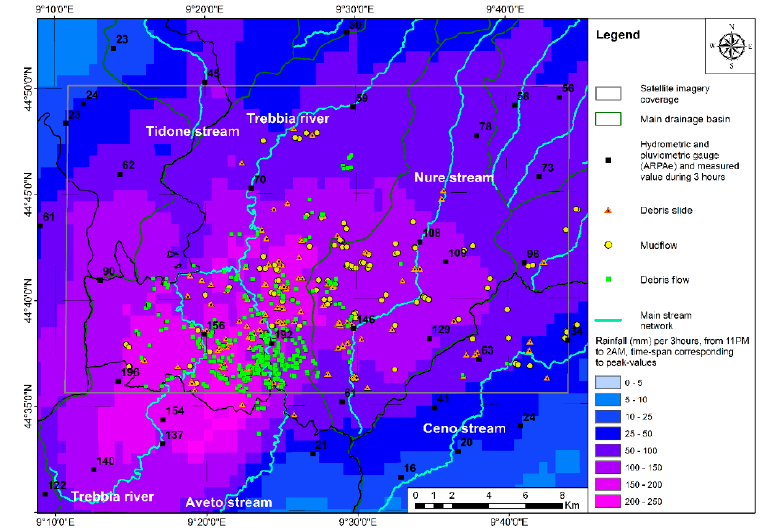
Figure 2. Rainfall estimates obtained from the combination of radar and surface rain gauge data. The time interval considered is from 11 p.m. 13th to 2 a.m. 14th September, it corresponds to the time period of rainfall maximum intensity. The main ground effects, that caused damages, are shown: 207 debris slides, 135 mud flows, and 286 hillslope-debris and hyperconcentrated flows.